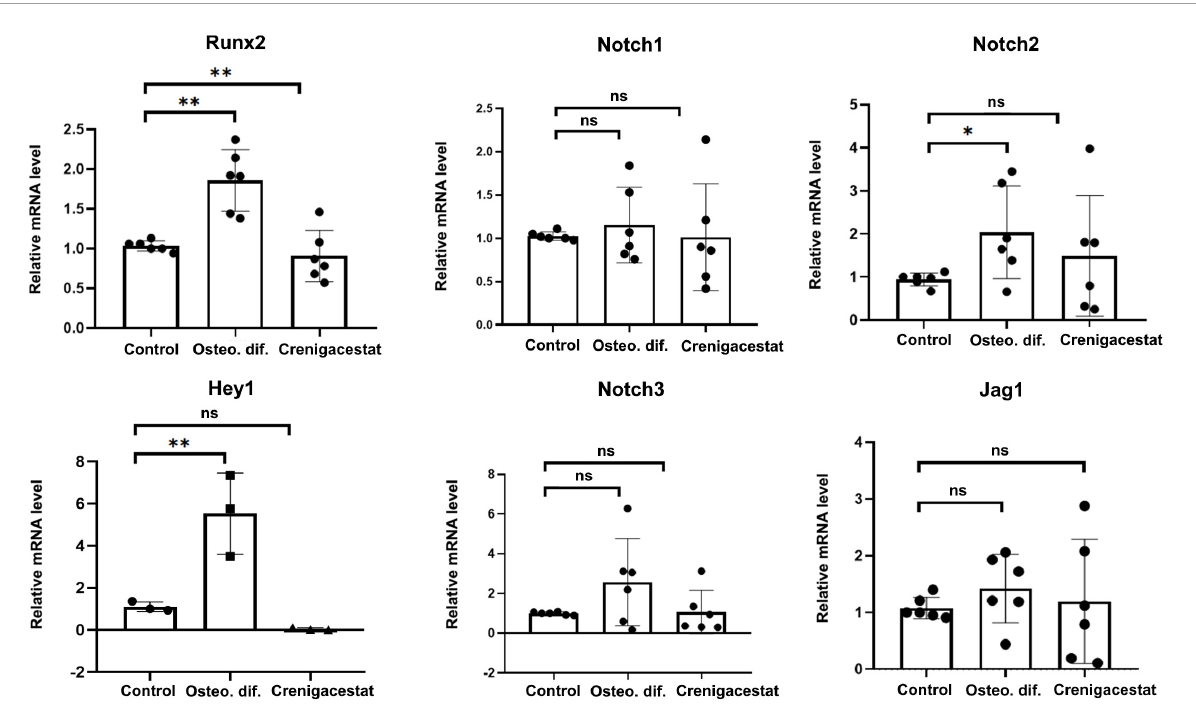
FIGURE3 Effect of crenigacestat (LY3039478) on Runx2 (the main regulatory gene of osteogenic differentiation), Hey1 (one of the main Notch target genes) and components of Notch-signaling (Notch1-3, Jag1) in control cells (Control), cells treated with osteogenic medium (OM), and cells treated with osteogenic medium and 100 nM of crenigacestat (OM + cre). Groups were compared using ANOVA, ∗ P < 0.05, ∗∗ P <